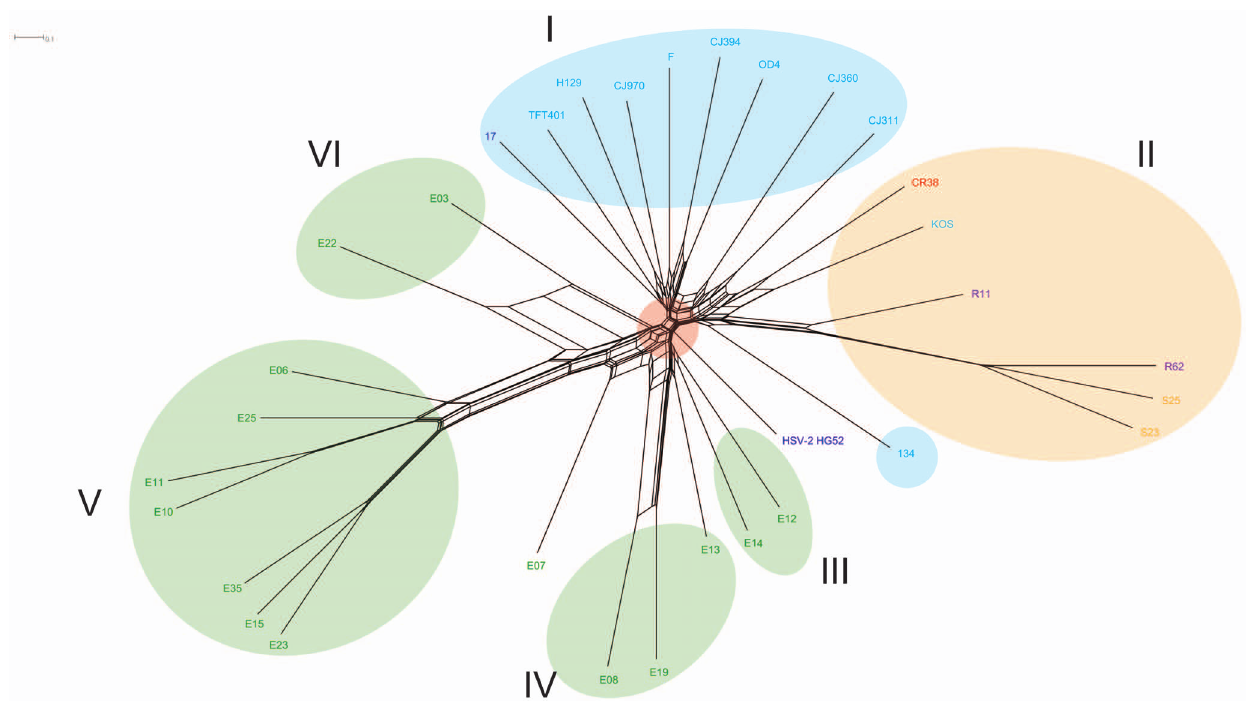
Figure 3. Consensus network constructed from 26 alignment partition consensus trees. The genome alignment was partitioned into 5 kb sections. Each partition underwent ML analysis with 500 bootstrap replicates. A consensus tree (70% confidence threshold) was constructed for each partition, and a consensus network was generated from the combined results using Splitstree 4. Clade I includes European/North American strains, Clade II comprises North American/East Asian strains and III, IV, V and VI are East African HSV-2 was used as an outgroup. The viral isolates are colored according to country of origin and are as follows: U.S.A: light blue, U.K.: dark blue, China: red, South Korea: purple, Japan: orange, and Kenya: green.